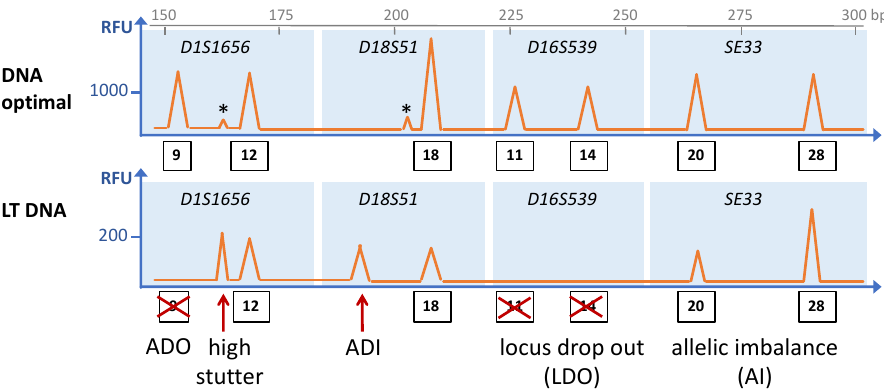
Figure 1. Schematic depiction of an electropherogram of an STR analysis showing the common stochastic effects of low template (LT) DNA ( bottom panel) as compared to optimal DNA amounts ( upper panel) from the same individual. The STR loci are indicated in italics, and the blue rectangles encompass the size ranges of amplicons of the particular STR loci. Thus, peaks within that range are assigned to the respective STR loci, and numbers in rectangles indicate the allele numbers of the peaks. Asterisks indicate stutter peaks. ADO: allele drop-out; ADI. Allele drop-in. The fragment length in base pairs (bp) is indicated on the x-axis on top, and the y-axis represents the peak height in relative fluorescence units (RFU). Please note the different scale in RFUs between the two panels.